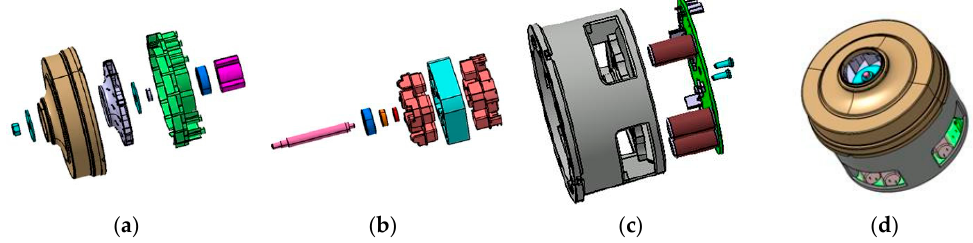
Figure 16. 3D model structure of the automotive vacuum cleaner using the proposed SRM. ( a ) Impeller mechanism; ( b ) The two-phase 4/2 pole SRM; ( c ) Motor housing & integrated converter; ( d ) Two-phase 4/2 pole SRM 3D modeling.